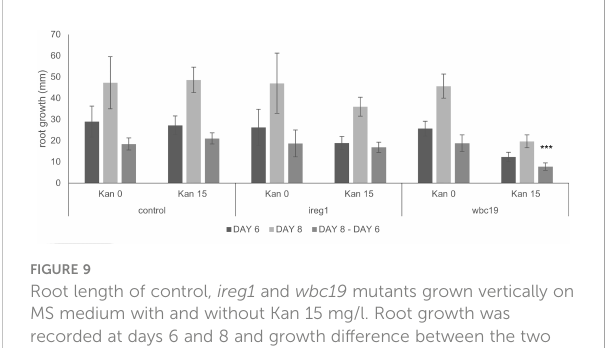
FIGURE 9 Root length of control, ireg1 and wbc19 mutants grown vertically on MS medium with and without Kan 15 mg/l. Root growth was recorded at days 6 and 8 and growth difference between the two dates was calculated. *** denotes p <0.001 when compared to root growth difference when no Kan (Student t